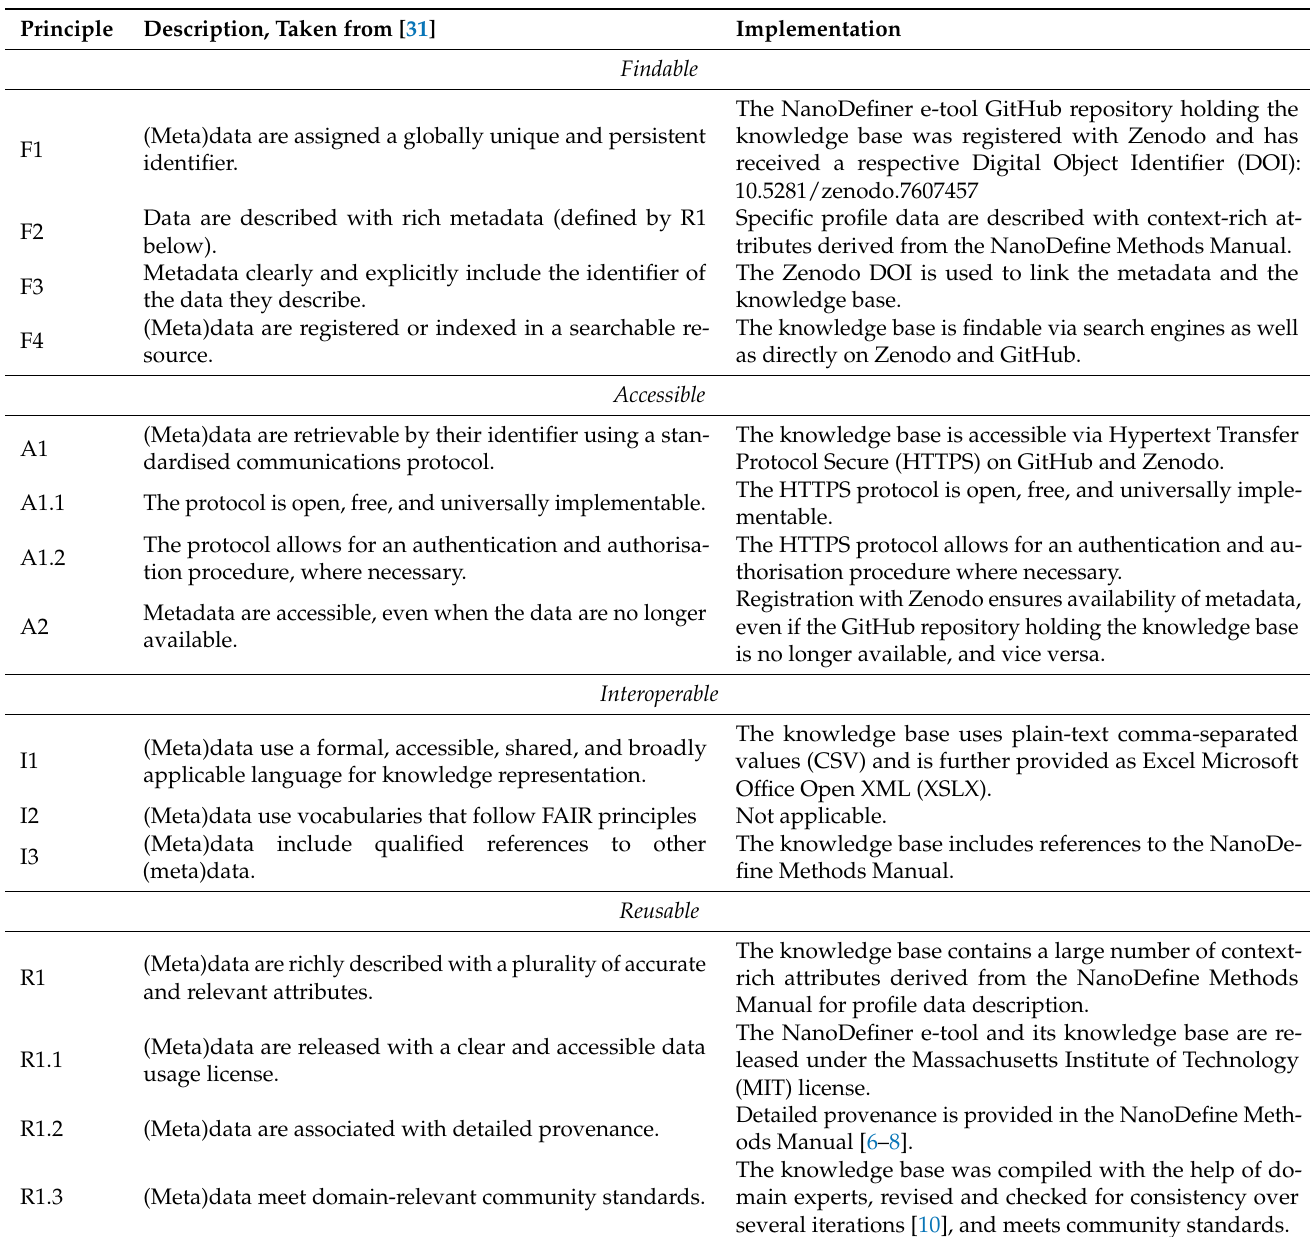
Table 1. FAIR principles and their implementation for the NanoDefiner e-tool knowledge